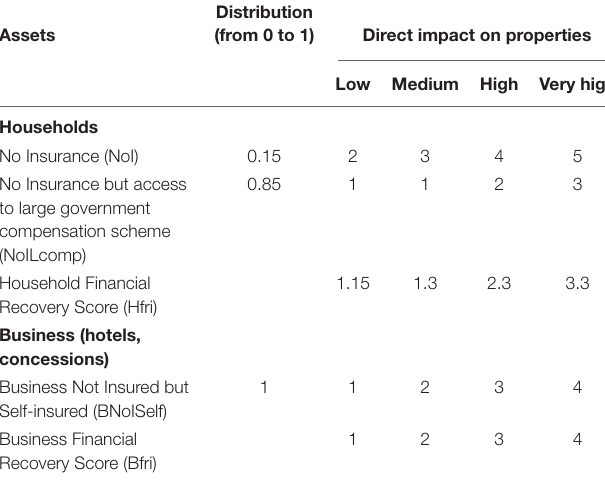
TABLE 6 | Financial recovery mechanisms in relation to the scores of the direct impact on properties and business activities. Distribution